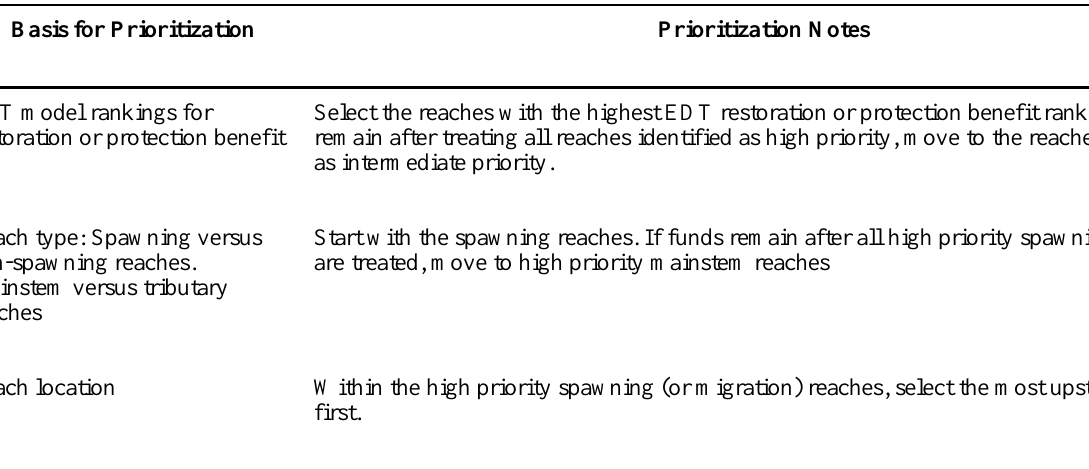
Table A1. The prioritization system for allocating funds to EDT reaches based on EDT output. Fifty percent of available funds were designated for restoration and 50% for protection. The same reach-level prioritization system was used to allocate funds independently for restoration and for